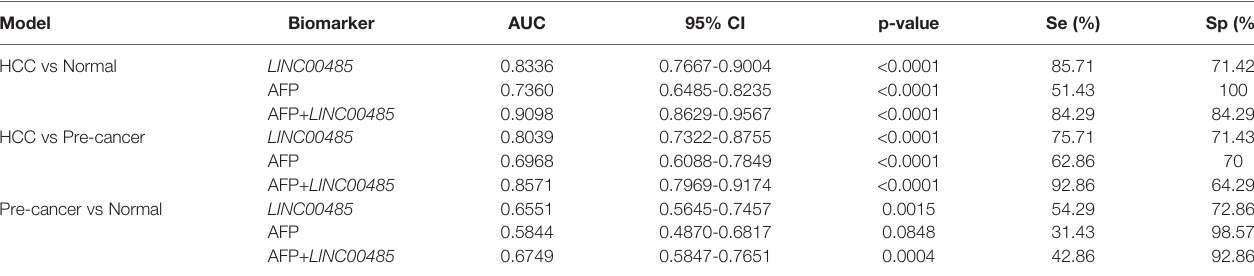
TABLE 2 | Comparisons of the diagnostic value of LINC00485 , AFP and AFP combined LINC00485 in three models.